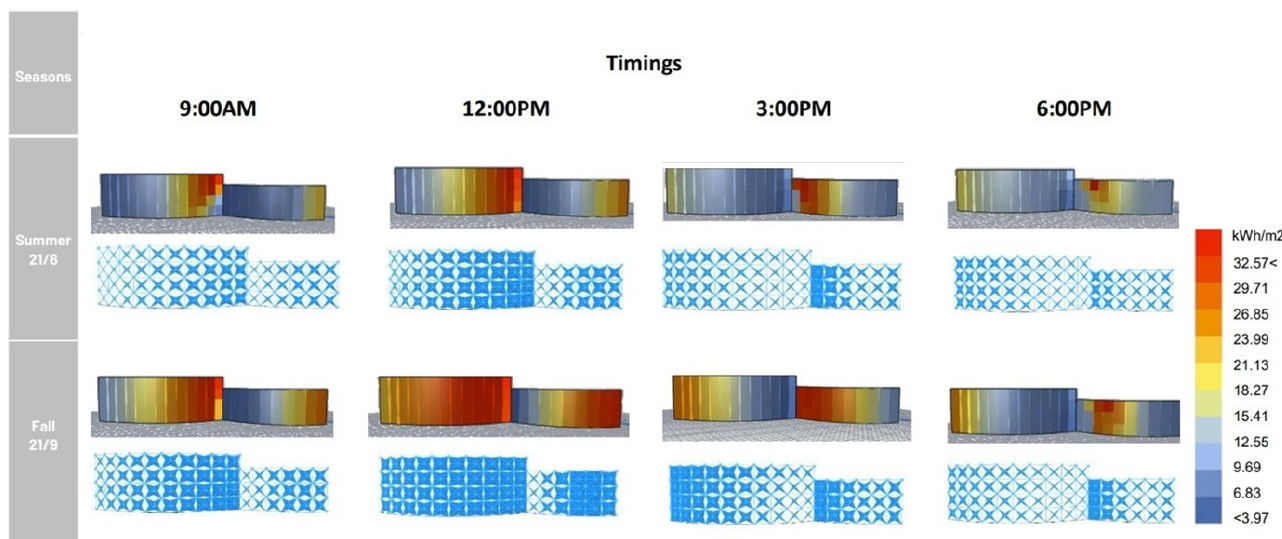
Figure 22. Analysis of the façade during the summer and fall in pique hours based on the solar radiation.